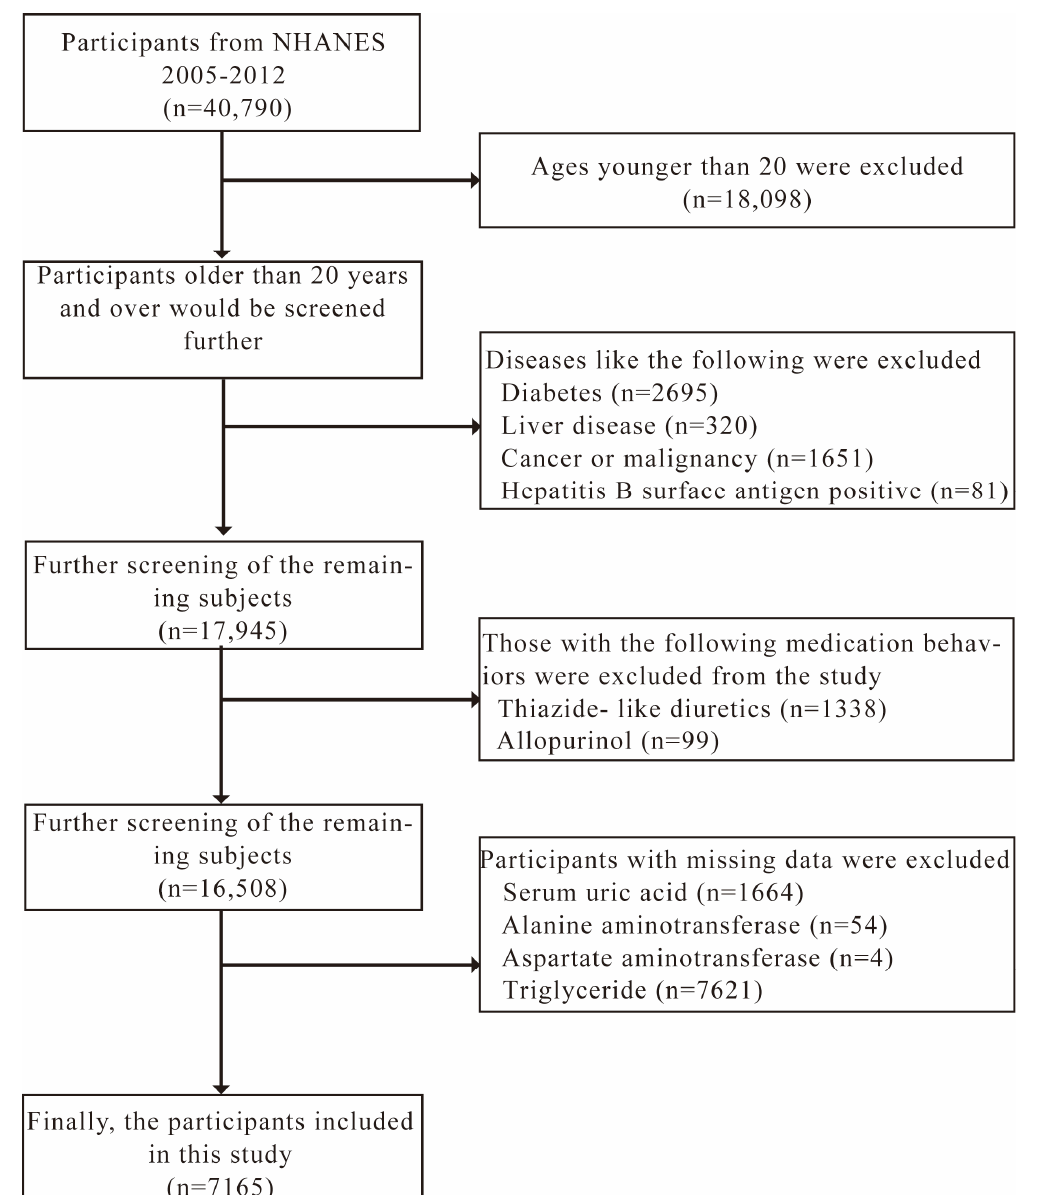
Figure 1. Flowchart of the participant screening process.